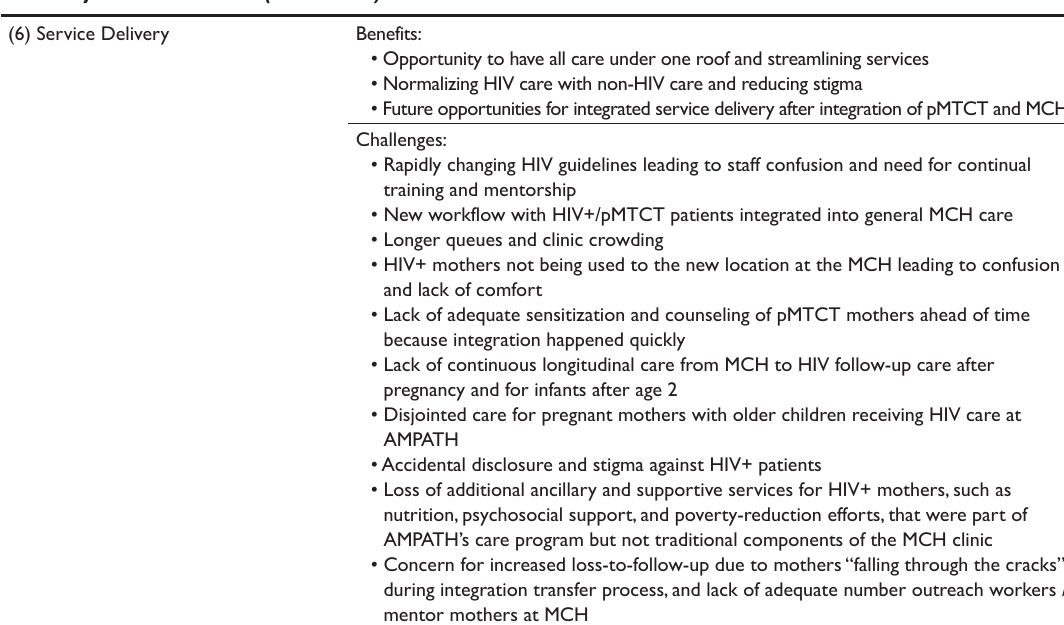
Table 1: Benefits and challenges of pMTCT – MCH integration organized by the WHO’s six critical health systems functions